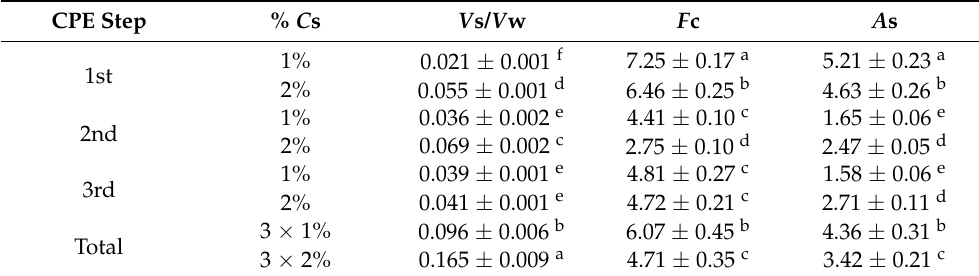
Table 2. Consecutive CPE extraction steps for the recovery of carotenoids from LTW.